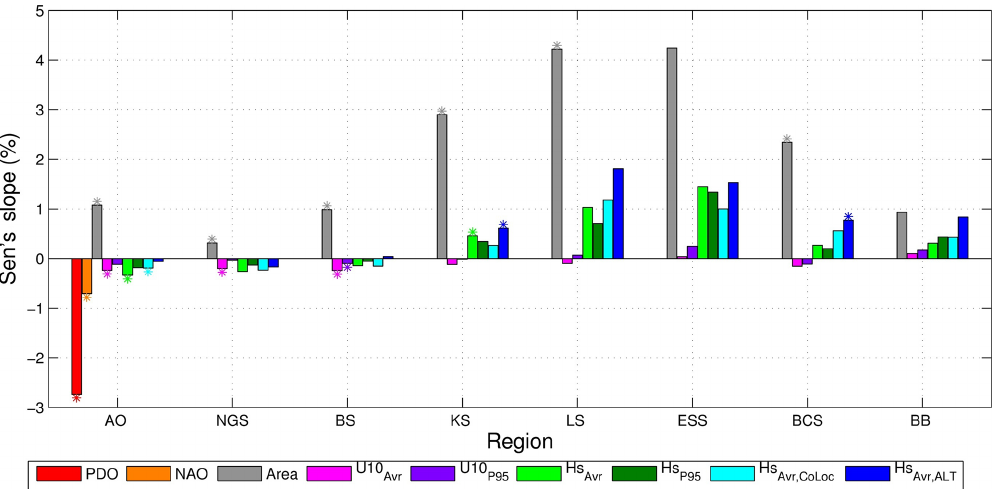
Figure 9. Sen’s slope with the Mann–Kendall test (denoted by a *) for the Arctic regions of the Arctic Ocean (AO), Nordic Greenland Sea (NGS), Barents Sea (BS), Kara Sea (KS), Laptev Sea (LS), East Siberia Sea (ESS), Beaufort–Chukchi seas (BCS), and the Baffin Bay (BB) from monthly time series of the North Atlantic oscillation (NAO), Pacific Decadal Oscillation (PDO), ocean area (Area), wind speed (U10), significant wave heights from the 3h model data ( H sAvr and H sP95 ), and co-located model and altimeter data ( H sAvr , CoLoc , H sAvr , ALT